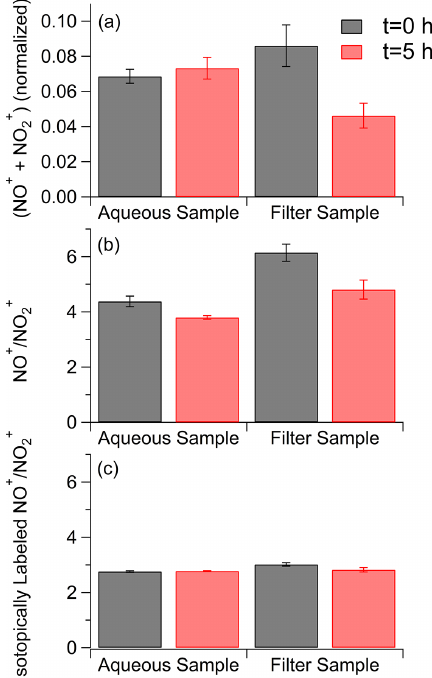
Figure 6. (a) Totals for the main fragment ions for nitrogen- containing groups measured by aerosol mass spectrometry before (in black) and after 5h of photolysis (in red) in the aqueous phase and organic particle phase. NO + and NO + are normalized to an internal standard. (b) NO + : NO + ratios before (in black) and after 5h of photolysis (in red) for sam- ples aged in water and on the filter. (c) NO + : NO + for the isotopically labeled inorganic internal standard. Error bars represent 1 standard deviation over five